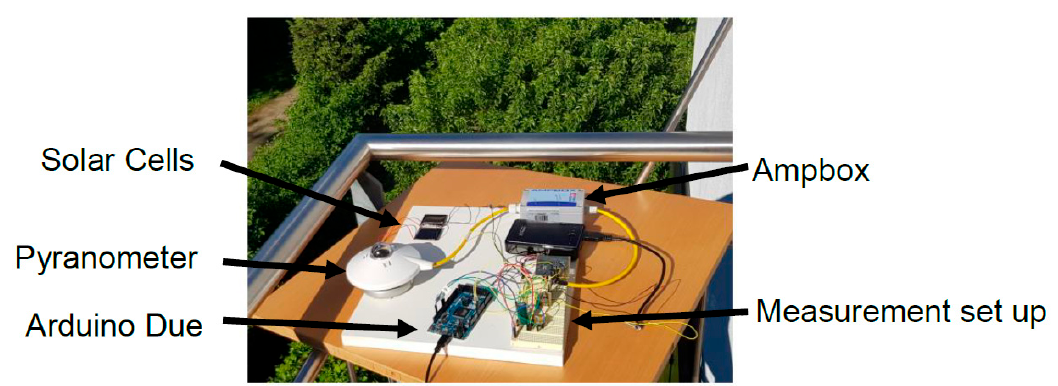
Figure 4. Picture of the setup placed onto a sunny